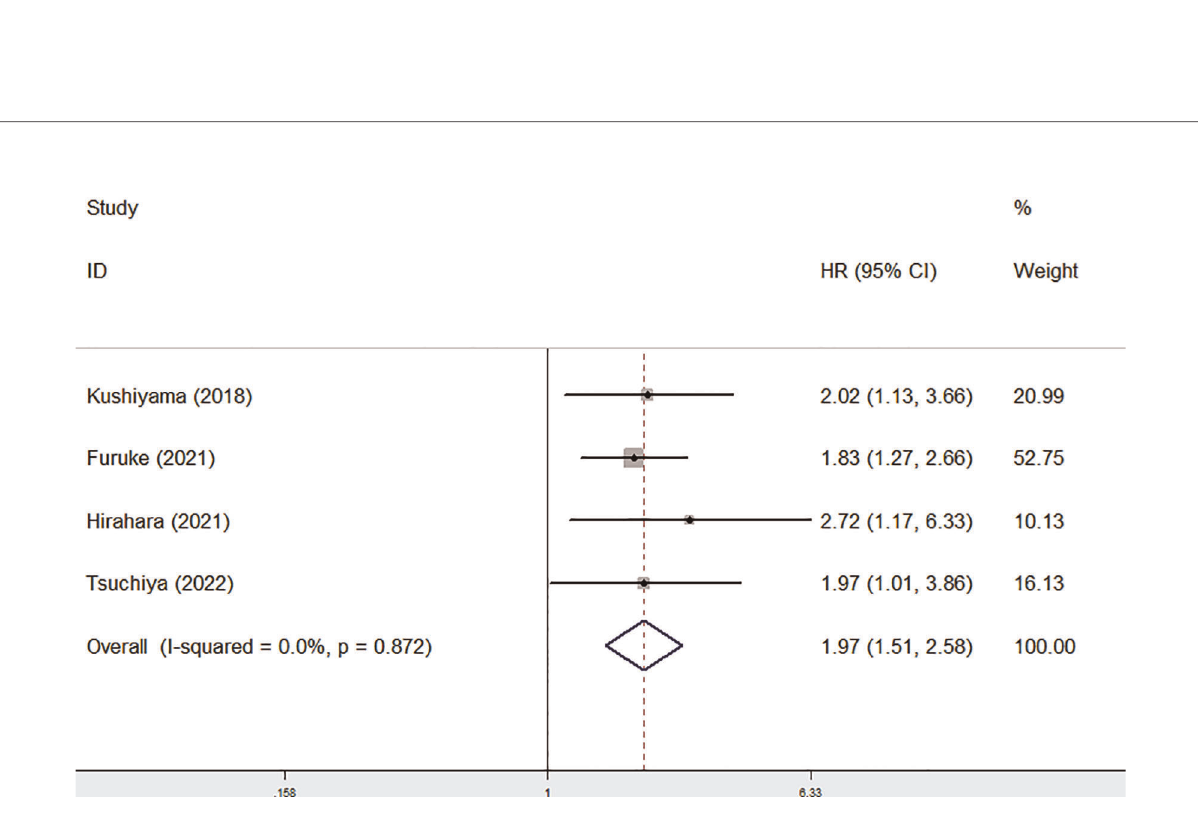
FIGURE 4 Sensitivity analysis for the association between preoperative geriatric nutritional risk index and overall survival of surgical gastric cancer